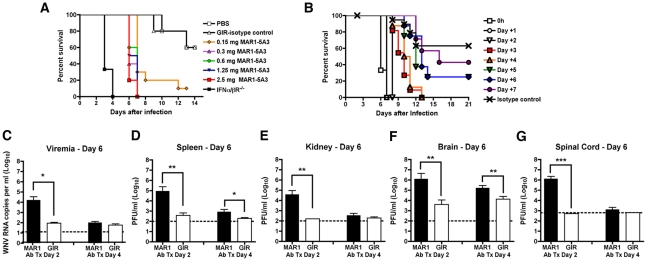
Effect of blockade of type I IFN signaling on WNV-NY infection.
A. Dose titration of the MAR1-5A3 MAb in mice. Mice (n = 10 per group) were treated with increasing doses of MAR1-5A3 MAb, infected one day later with 102 PFU of WNV-NY, and survival was monitored. All MAR1-5A3 treatment doses shown were statistically different compared to GIR-208 treatment (P<0.05). B. Time course of MAR1-5A3 addition after WNV infection. Mice (n = 5 to 10 per group) were infected with 102 PFU of WNV-NY, treated with 1 mg of MAR1-5A3 or an isotype control (GIR-208 (GIR)) at different times after infection, and survival was determined. Treatment with MAR1-5A3 at days 0, 1, 2, 3, and 4 were statistically different (P<0.004) compared to treatment with GIR-208. C–G. Effect of MAR1-5A3 on viral burden. Mice (n = 5 to 10 per group) were infected with 102 PFU of WNV-NY, treated with 1 mg of MAR1-5A3 or GIR at day 2 or day 4 after infection. (C) Serum, (D) spleen, (E) kidney, (F) brain, and (G) spinal cord were harvested at day six and viral titers were determined by plaque assay or qRT-PCR. Asterisks indicate differences that are statistically significant (*, P<0.05; **, P<0.01, ***, P<0.001).